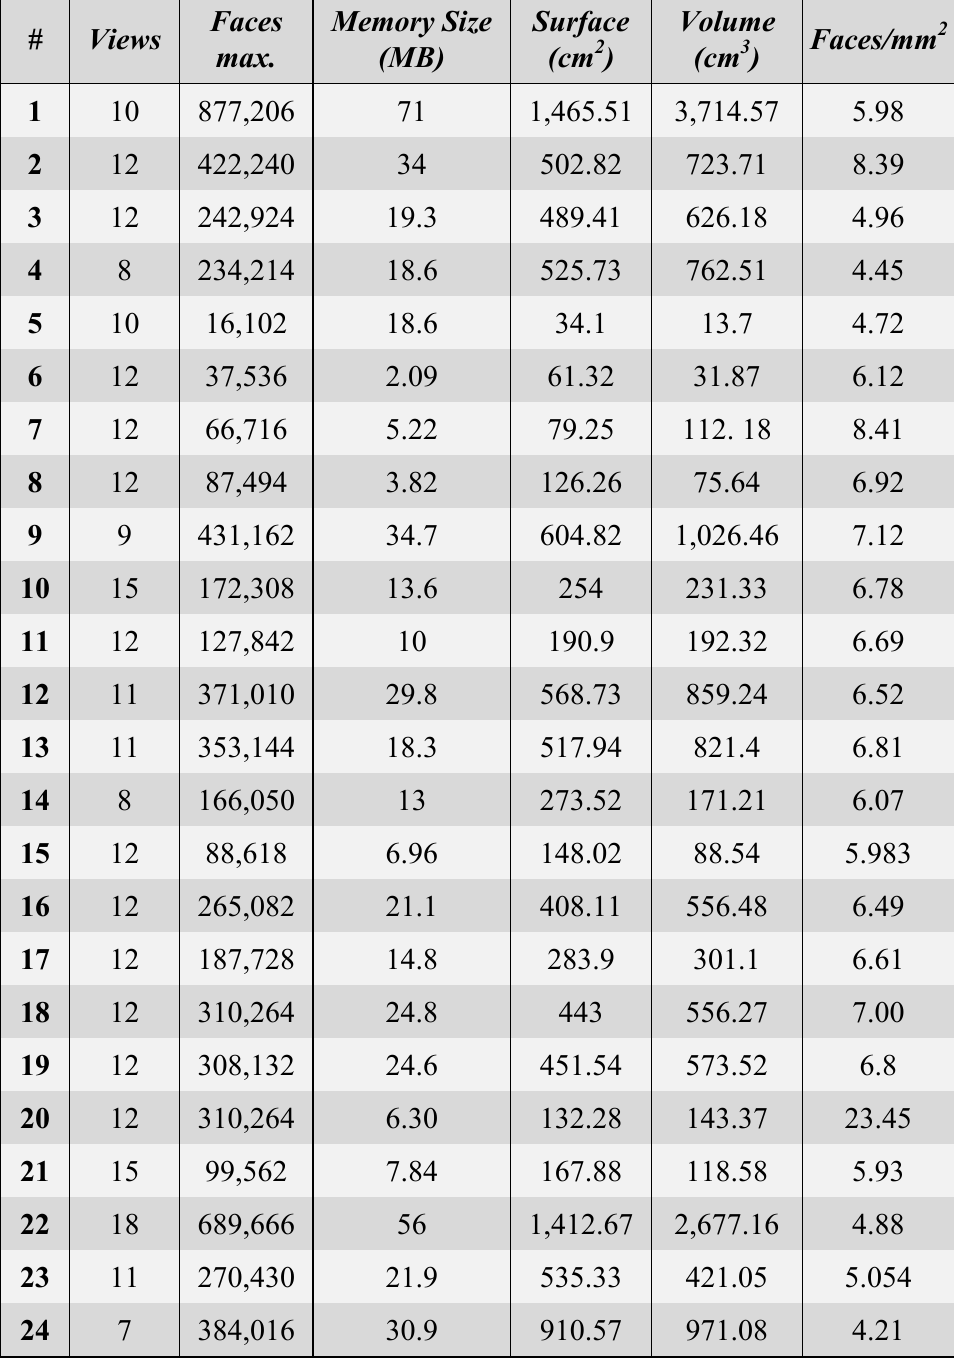
Table 3. Data for the geometrical models of the small